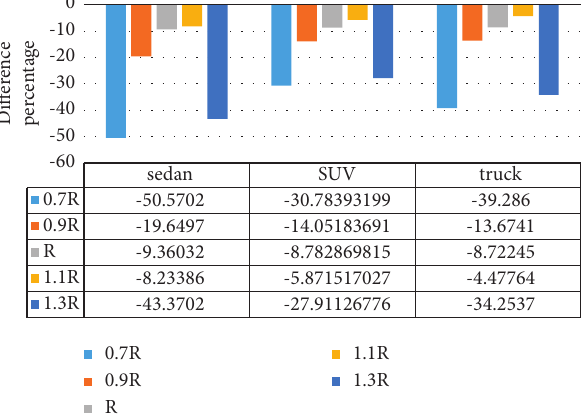
Figure 17: Difference percentage between the maximum roll rates of the simple and spiral horizontal curves with respect to the simple horizontal curve for the speed of 100km/h and various percentages of radius.